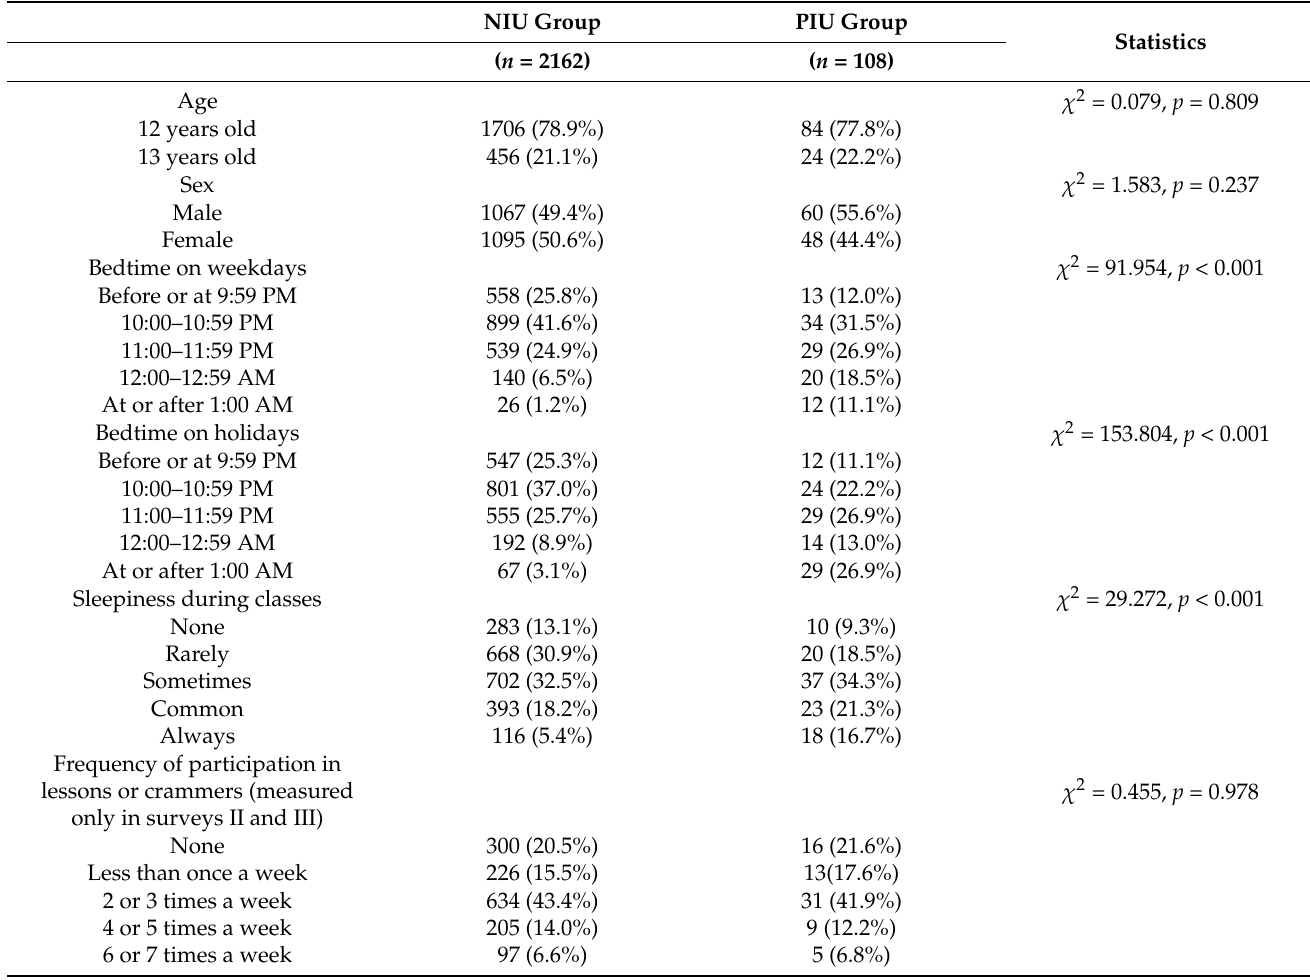
Table 3. Comparisons of age, sex, bedtime, sleepiness during classes, and frequency of participation in lessons or crammers between the study